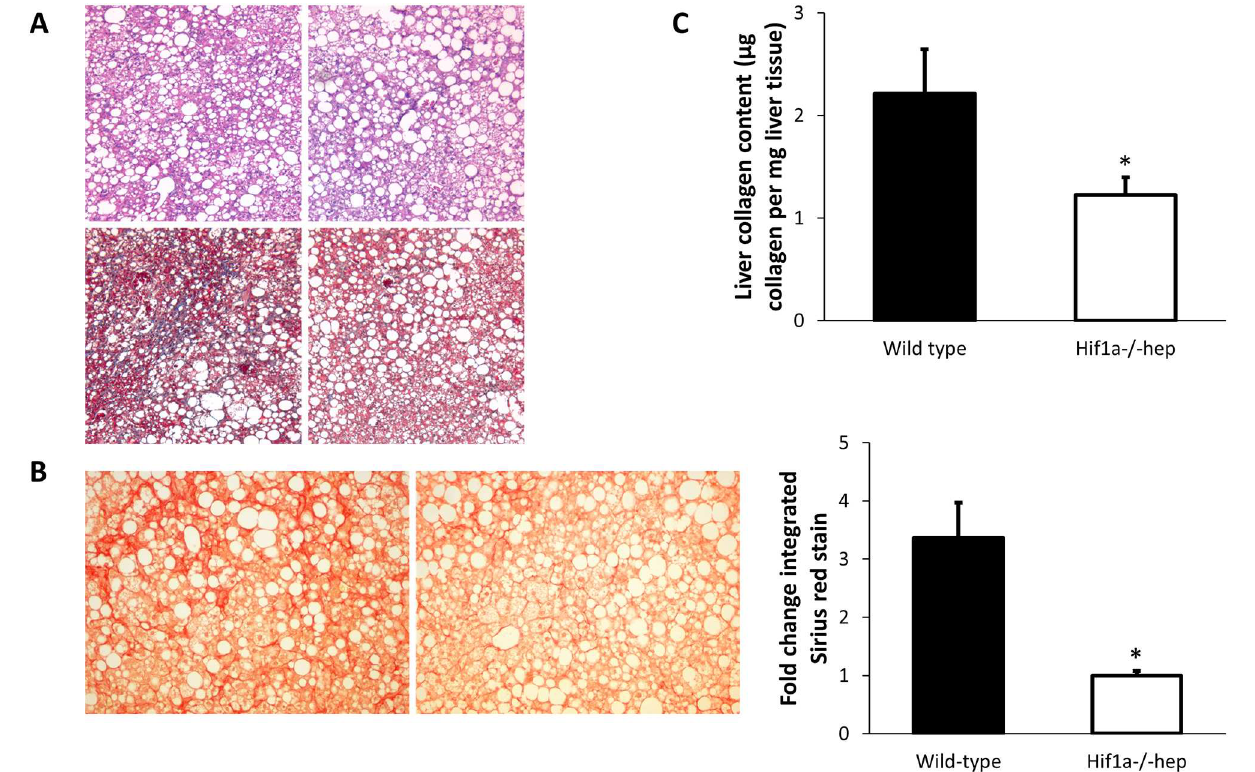
Fig 4. Liver histology and collagen quantification. (A) Representative liver H&E (top) and Masson’s trichrome stains (bottom) from wild- type (left) and Hif1a -/- hep mice. More fibrosis can be observedin the wild-typemice in the Masson’strichrome stain. (B) Sirius red stain of collagenin wild-type(left) and Hif1a -/- hep mice (right). (C) Collagencontent of all samples by use of hydroxyproline assay. * , p < 0.05.